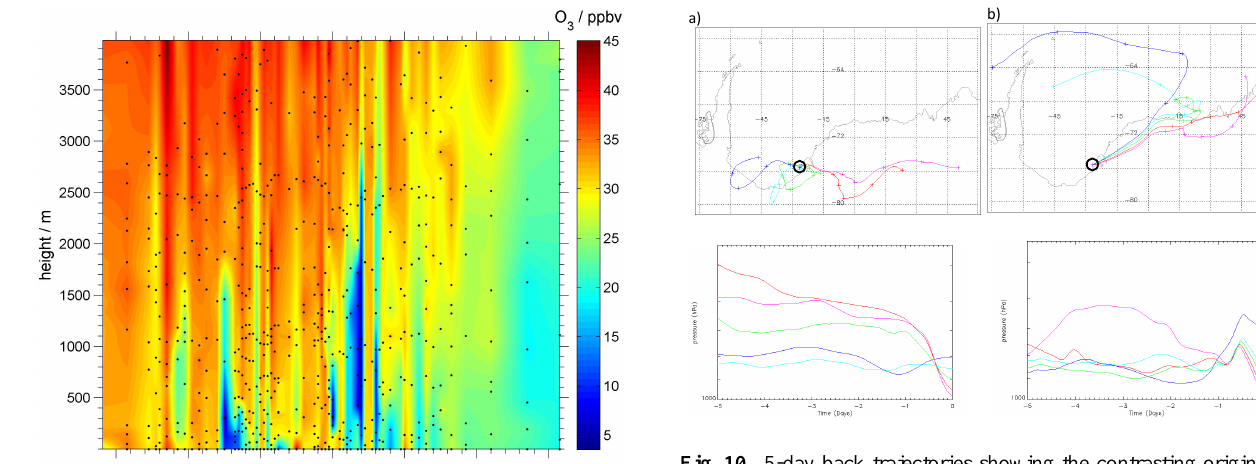
Fig. 10. 5-day back trajectories showing the contrasting origin of air arriving at different altitudes at Halley. (a) 21 September 1987: the pink and red trajectories correspond to air arriving at 980 and 950hPa respectively; the green, turquoise, and blue lines are the trajectories for air parcels arriving at Halley at 900, 850 and 800hPa respectively (i.e. between ∼ 1km and ∼ 2km above ground level – the altitude region of low ozone air in the profile on this day). (b) 28 September 1987: the pink and red trajectories correspond to air arriving at 980 and 950hPa respectively; the green, turquoise, and blue lines are the trajectories for air parcels arriving at Halley at 900, 850 and 700hPa respectively (i.e. between ∼ 1km and ∼ 3km above ground level – the altitude region of low ozone air in the profile on this day). Halley is marked by the black circle on the plot; trajectory markers are at 24h